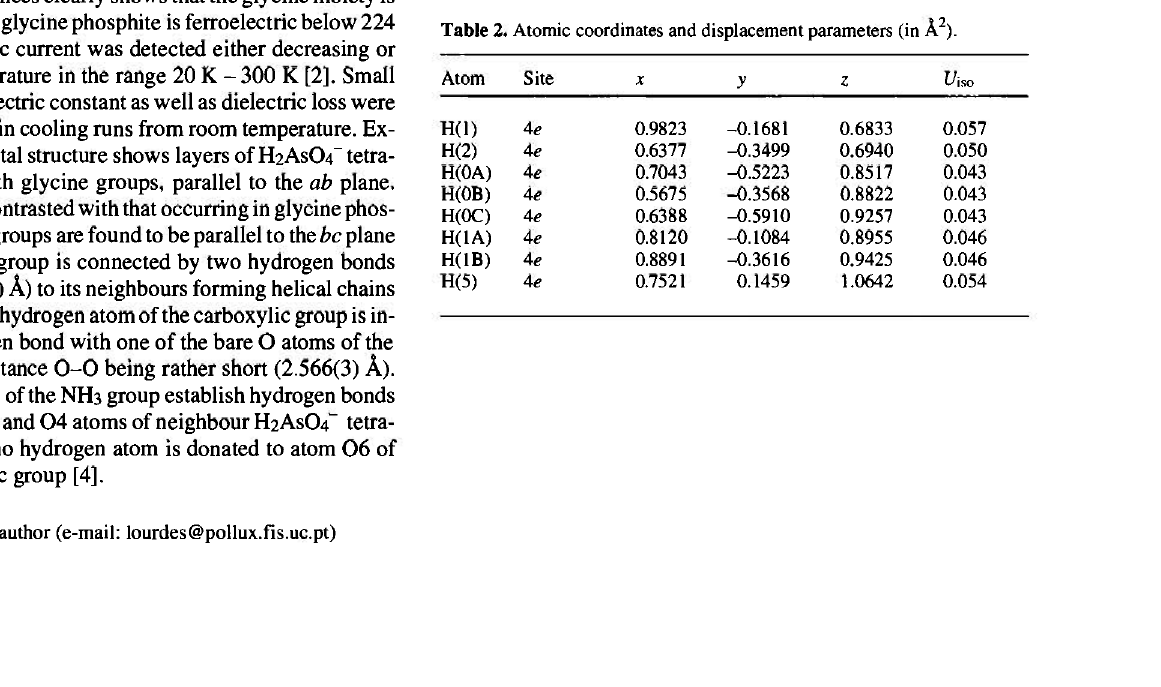
Table 1. Data collection and handling.